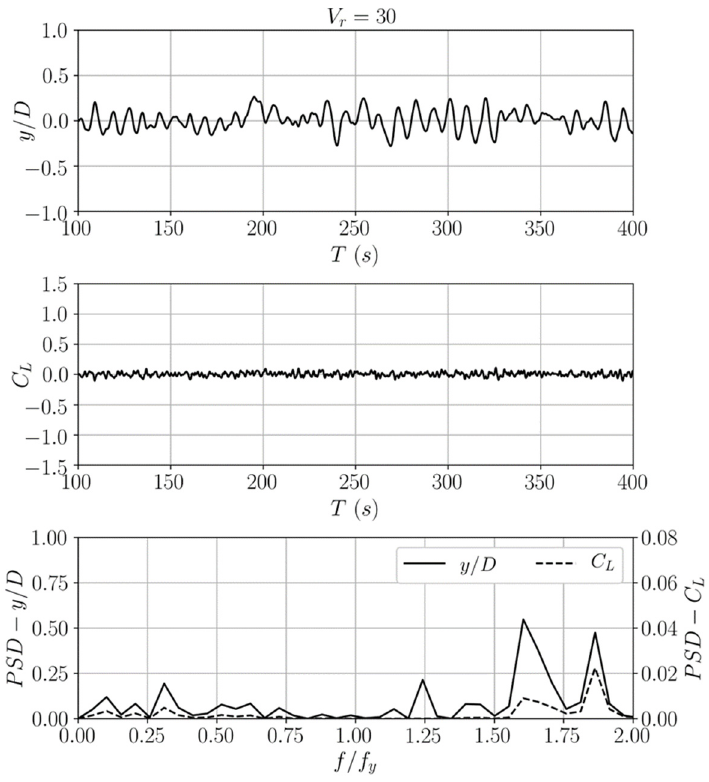
Figure 12. Time series and PSD of transverse response and force coefficient of FOWT platform with α = 180 ◦ , at various V r